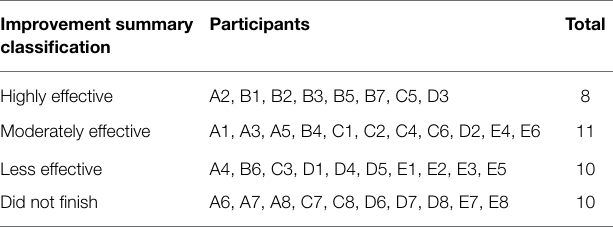
TABLE 6 | Summary of improvements for all